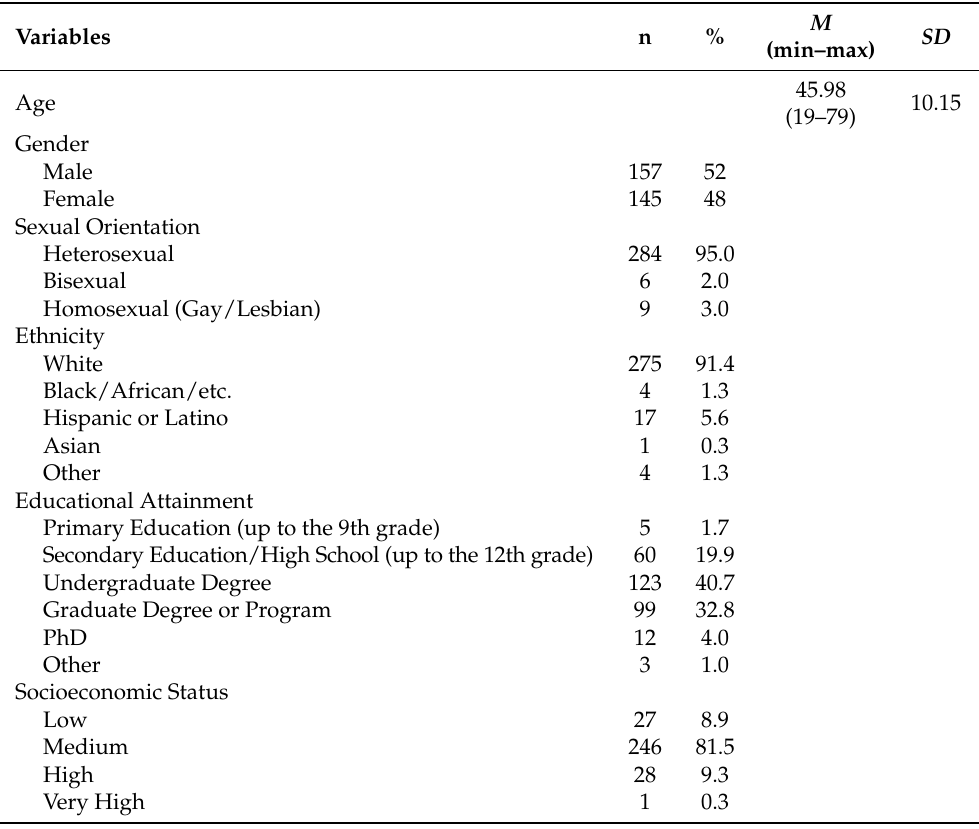
Table 1. Sociodemographic